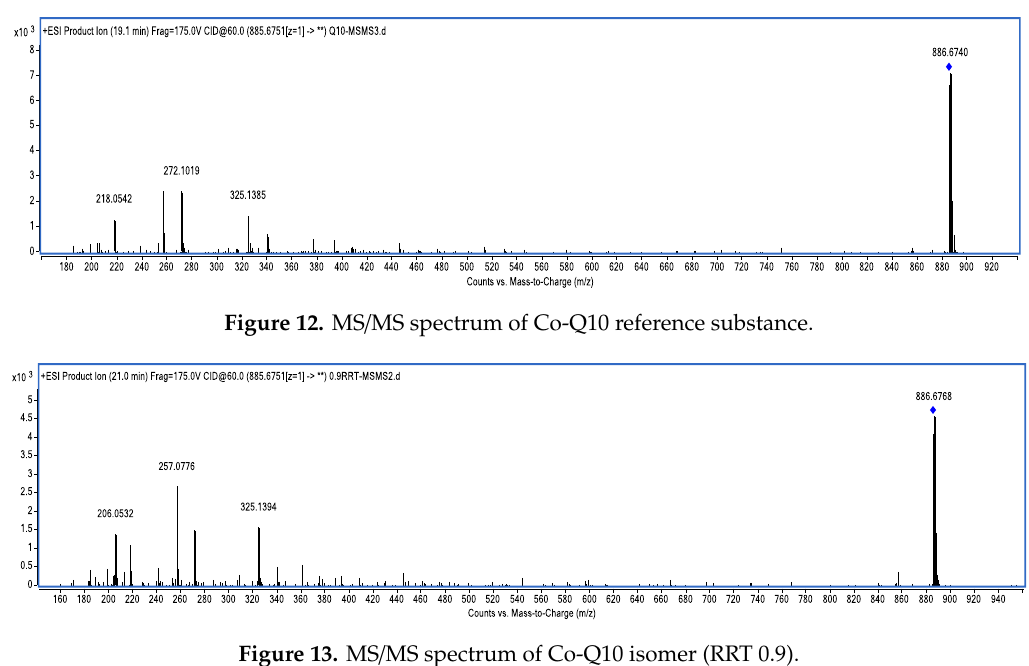
Figure 13. MS / MS spectrum of Co-Q10 isomer (RRT Figure 13. MS/MS spectrum of Co-Q10 isomer (RRT 0.9). Figure 13. MS/MS spectrum of Co-Q10 isomer (RRT 0.9). Figure 13. MS/MS spectrum of Co-Q10 isomer (RRT 0.9).